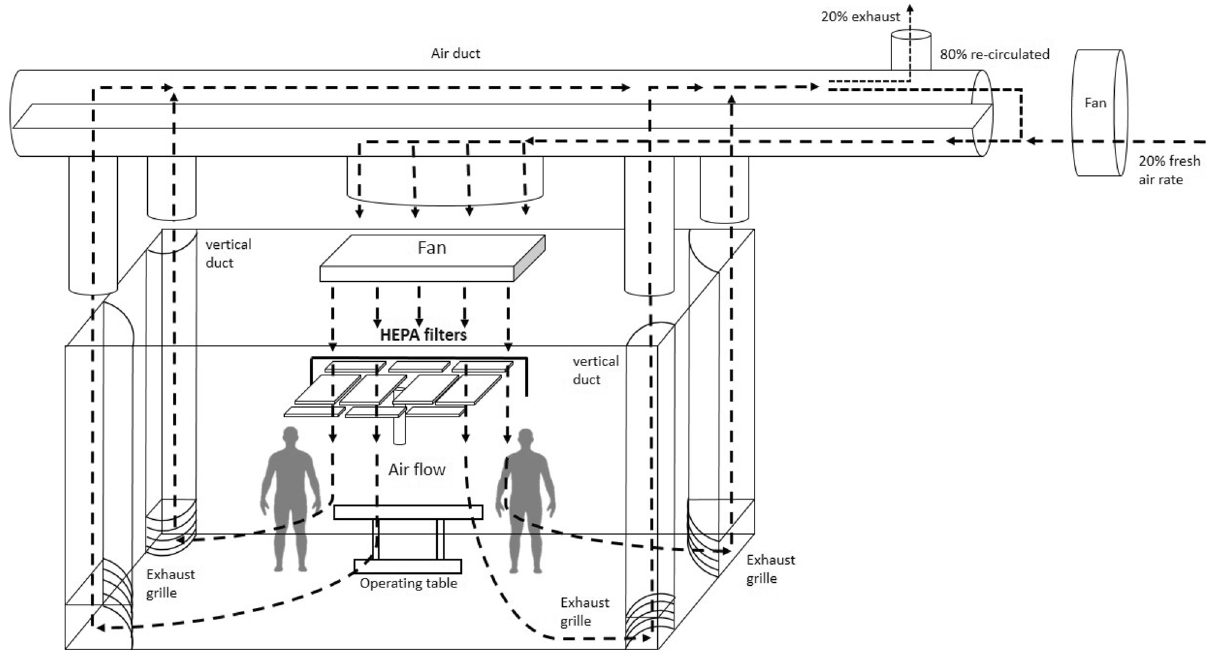
Figure 1. Schematic of air flow direction, air inlet and exhaust locations inside the operating